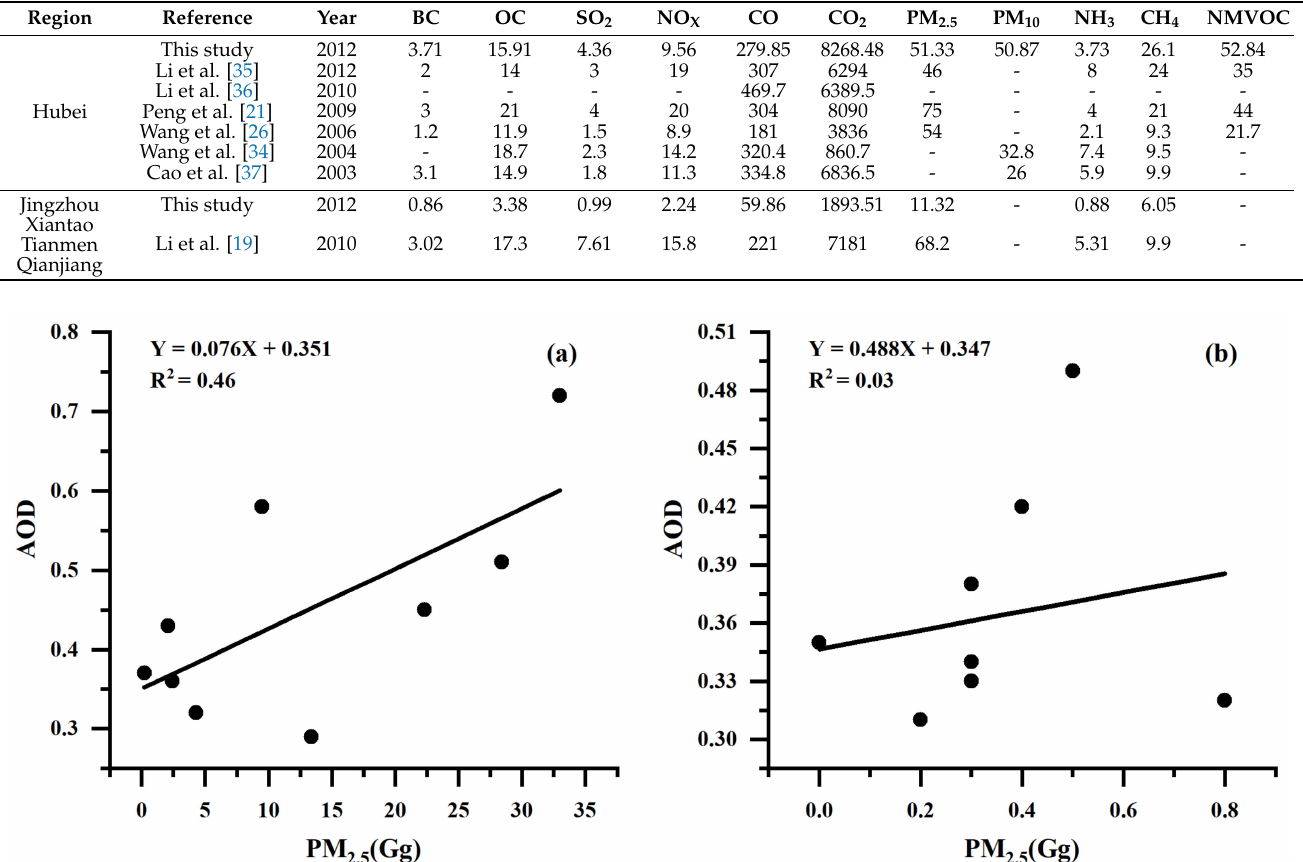
Table 6. Comparison of the emissions with previous studies in different years (Gg).